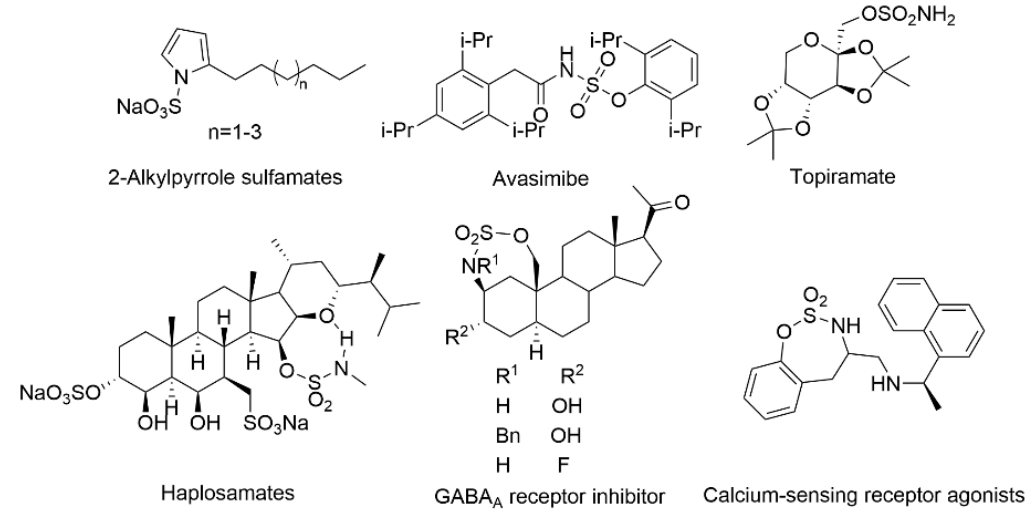
Figure 1. Representative examples of bioactive sulfamates.